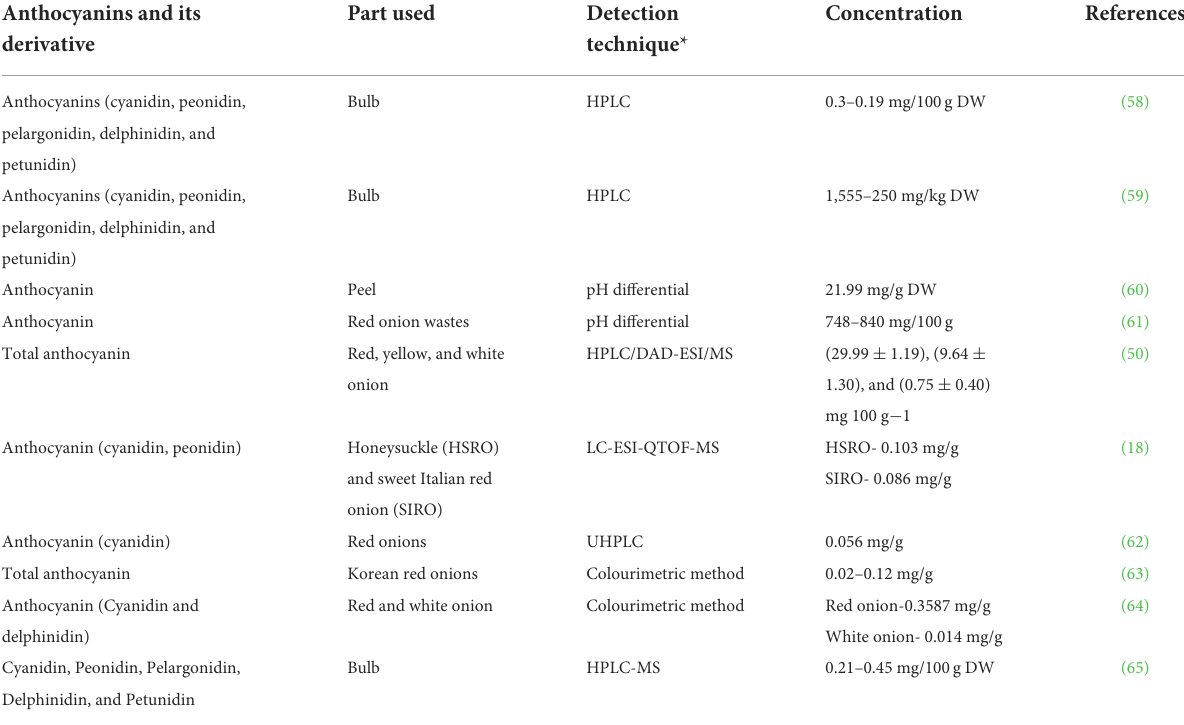
TABLE 1 Different anthocyanin concentrations present in onions and their detection techniques. Anthocyanins and its